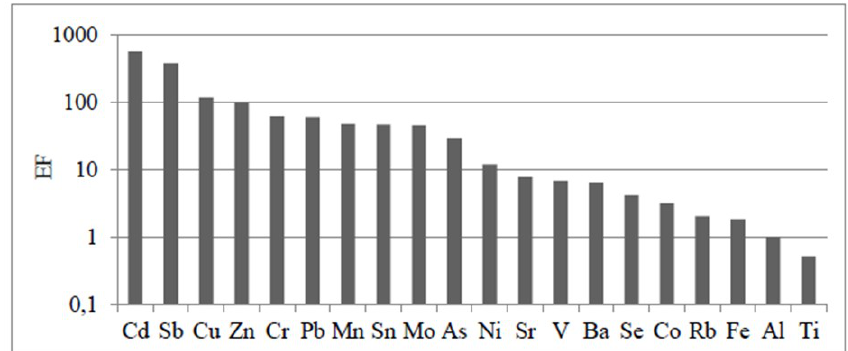
Figure 7. Average enrichment factors (EF) for trace elements in rainwater.